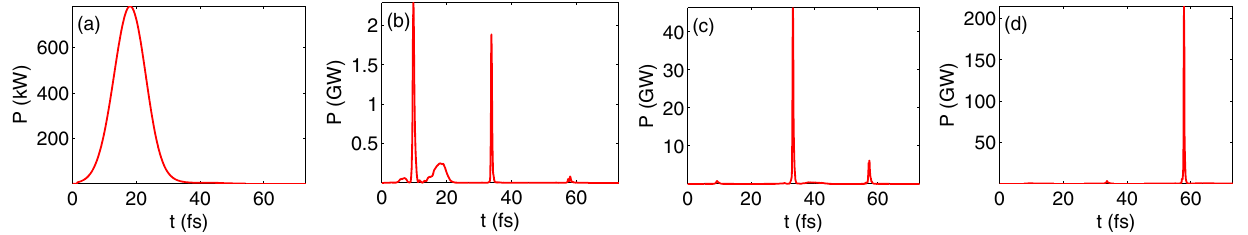
FIG. 5. An example of FEL power profiles at U2A entrance (a), U2A exit (b), U2B exit (c), and U2C exit (d) with a misalignment of 8 fs between the modulation laser and the electron bunch. Multi-spikes appear at the first amplifier stage (U2A), but the cascaded delay helps select the dominant